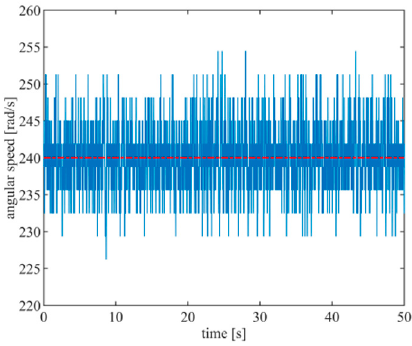
Figure 7. Time sequence of the measured angular speed in ADM in the ABL wind tunnel. The red dash–dotted line denotes the mean angular speed.